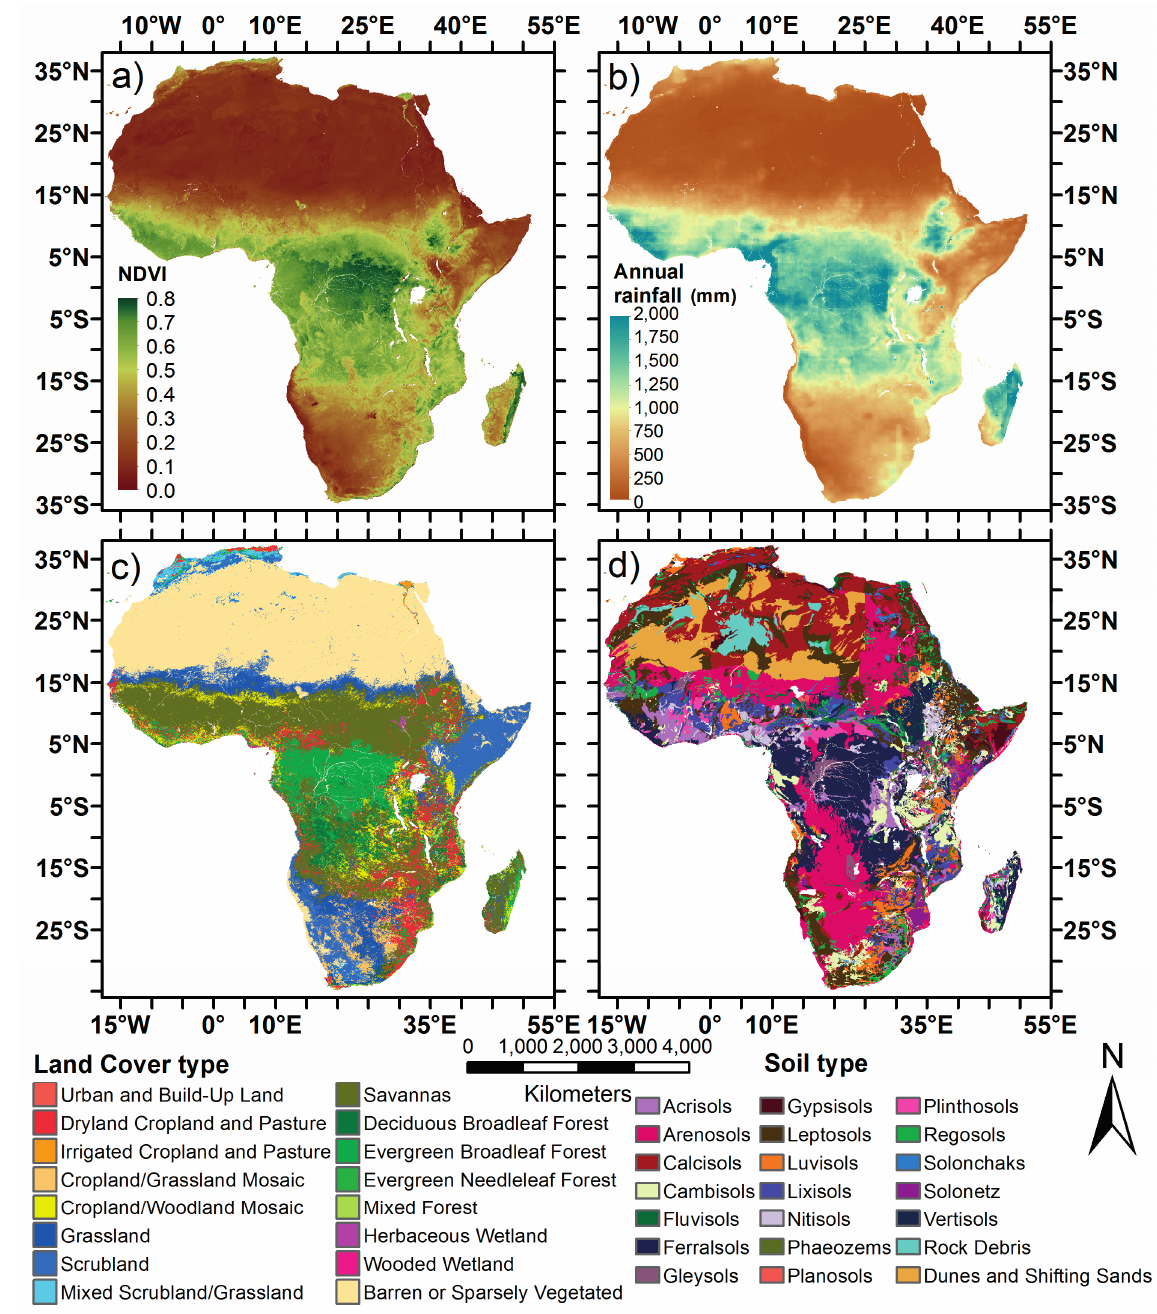
Figure 2. Ancillary datasets used for the evaluation: ( a ) mean yearly Normalized Difference Vegetation Index (NDVI) value from Moderate-Resolution Imaging Spectroradiometer (MODIS) NDVI measurements; ( b ) mean yearly precipitation from Tropical Rainfall Measuring Mission (TRMM) monthly rainfall data; ( c ) Land Use/Land Cover System from the U.S. Geological Survey Global Land Cover Characteristics; ( d ) Harmonized World Soil Database soil type